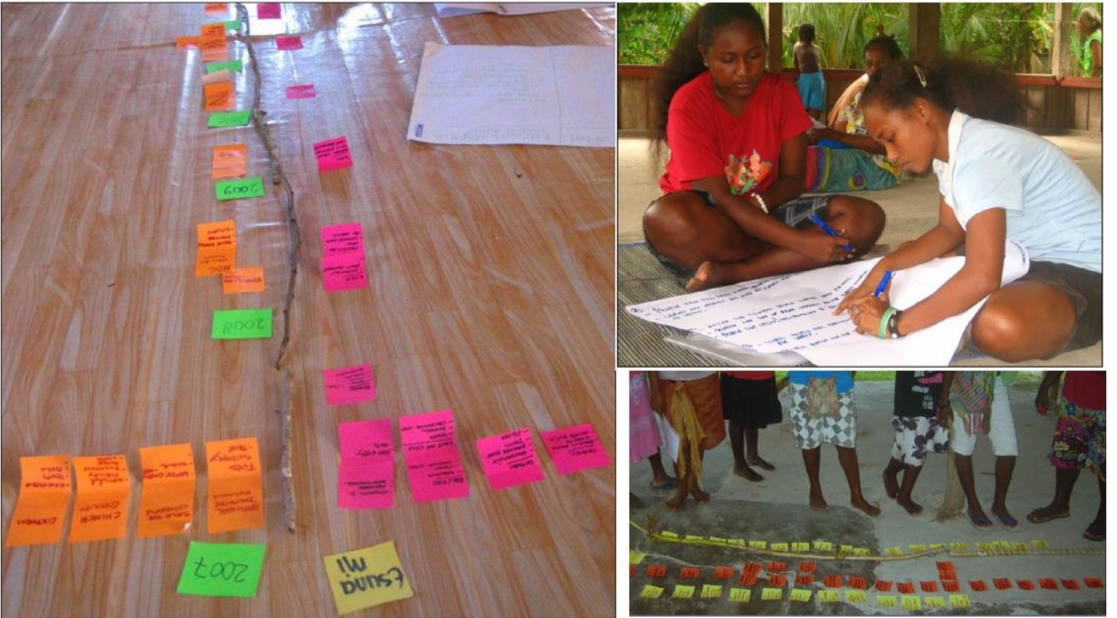
Figure 9. Timeline exercise within different villages documenting events that occurred at different stages of the disaster cycle. Timelines are critical knowledge pathways, allowing for a temporal analysis of events and a reconstruction of cause and effect in the correct order within a village/community experiential